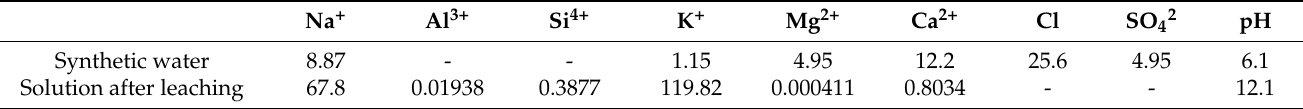
Table 2. The composition of the synthetic water before and after concrete leaching (10 − 4 , mol/L).